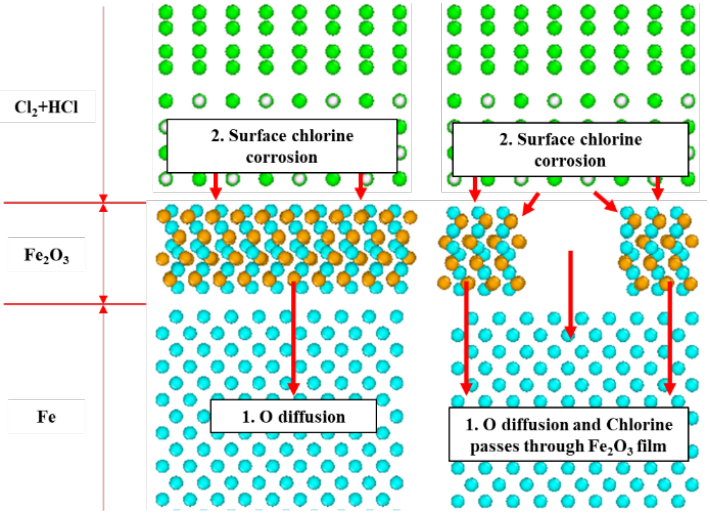
Figure 8. Corrosion diagram of model B. (Green is chlorine, white is hydrogen, aqua is iron and yellow is oxygen.)